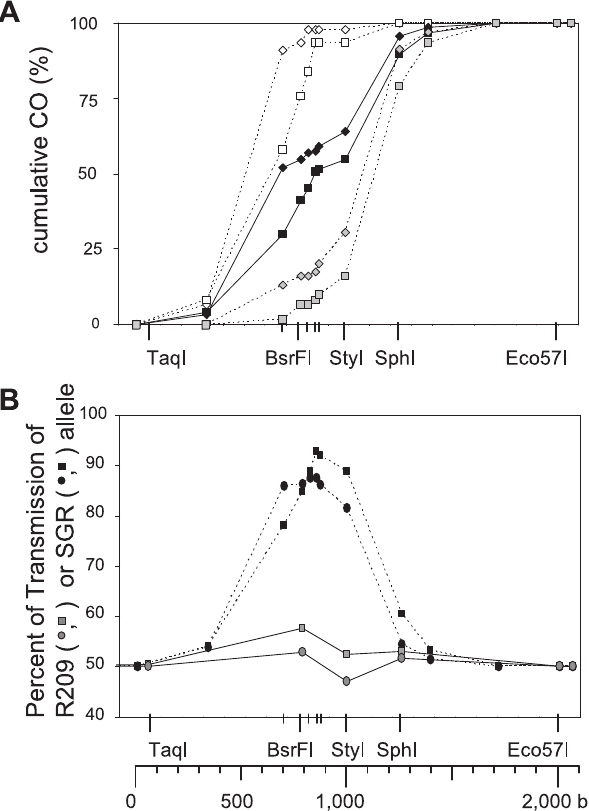
Figure 4. Cumulative CO Distribution and Transmission Bias in Males and Females (A) CO distribution in B10.A 3 SGR is presented: open diamonds, female, orientation B10.A-SGR; open squares, male, orientation B10.A-SGR; gray diamonds, female, orientation SGR-B10.A; gray squares, male, orientation SGR-B10.A; black diamonds, female, both orientations; black squares, male, both orientations. (B) Transmission bias among CO products is presented; transmission frequency of the wm7 allele in B10 3 R209 and B10.A 3 SGR. Gray circles and squares, B10 3 R209, female and male, respectively; black circles and squares, B10.A x SGR, female and male, respectively.